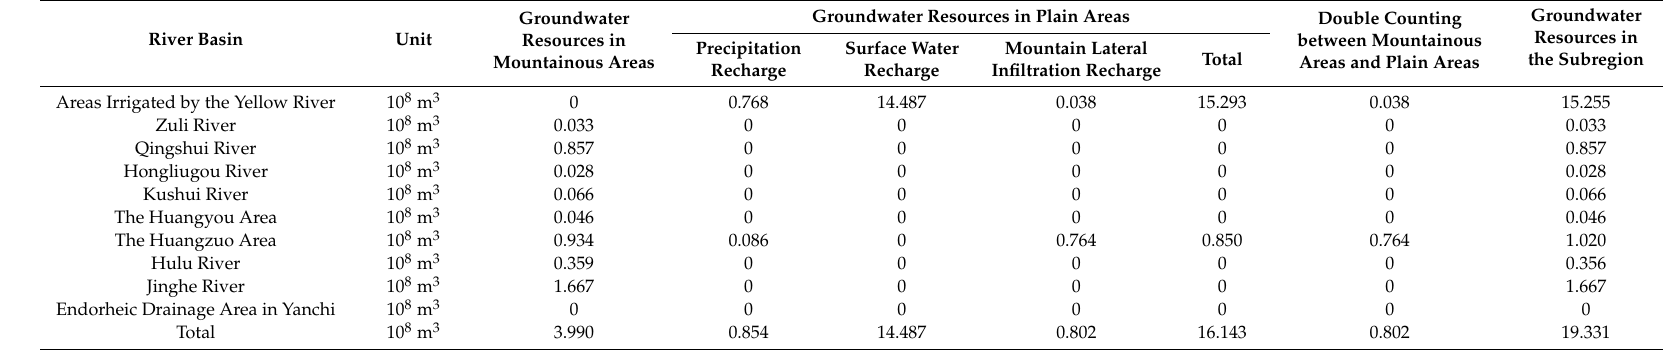
Table 1. Groundwater Resources in Ningxia Zoning by Basin Area for